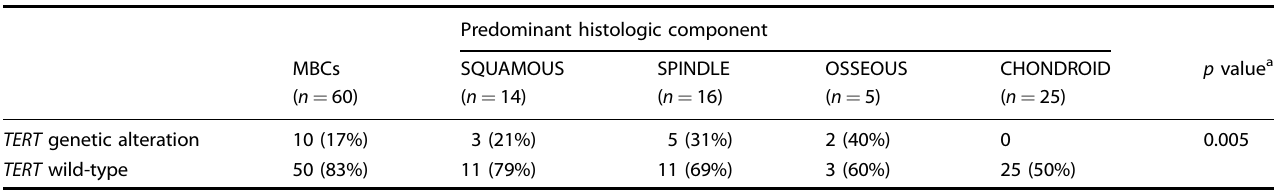
Table 2. Frequency of genetic alterations affecting TERT gene in 60 metaplastic breast cancers according to their predominant histologic component.